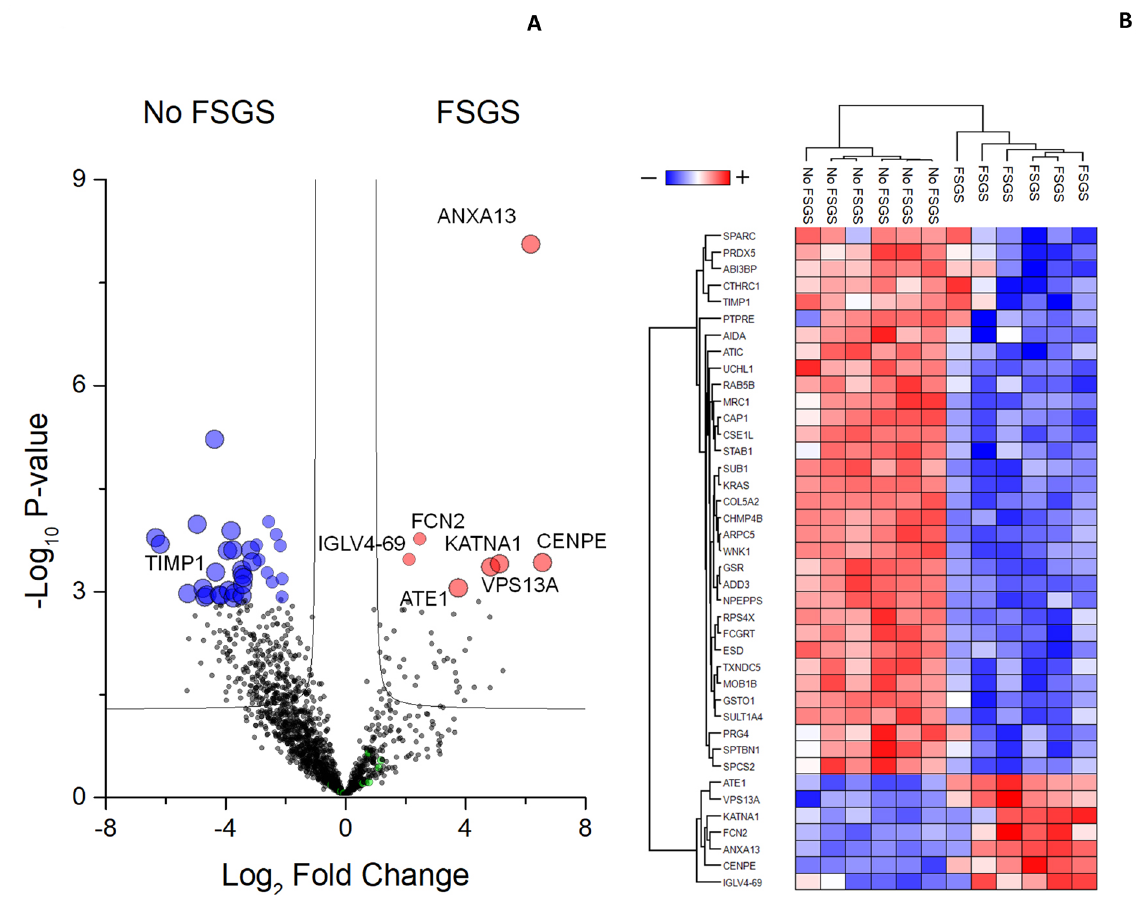
Figure 2. Volcano plot of univariate statistical analysis of peritoneal dialysis effluent exosomes from FSGS and No FSGS samples and heatmap of statistically significant proteins. ( A ) The plot is based on the fold change (log 2 ) and their p -value (− log 10 ) of all proteins identified in all samples. Red, blue, green and black circles indicate respectively the proteins with statistically significant up-regulation in FSGS or No FSGS